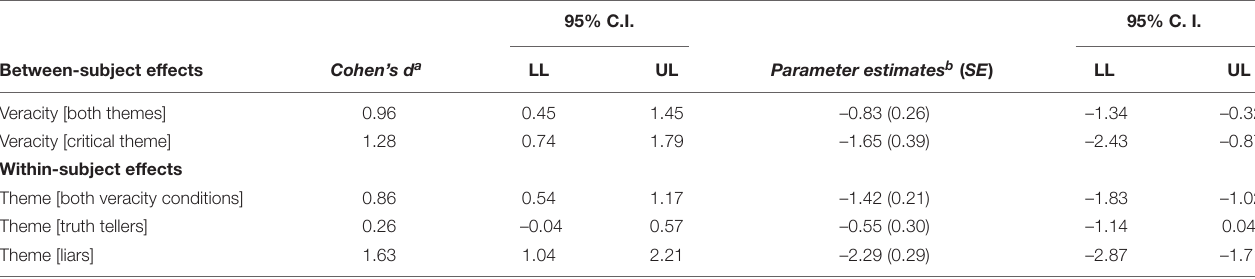
TABLE 1 | Between-subjects vs. within-subjects effect sizes and parameter estimates comparisons. 95% C.I. 95% C. I.